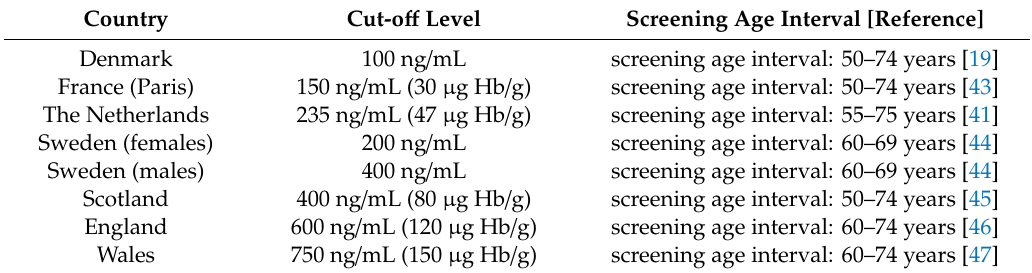
Table 1. Cut-o ff levels for FIT CRC screening in various European